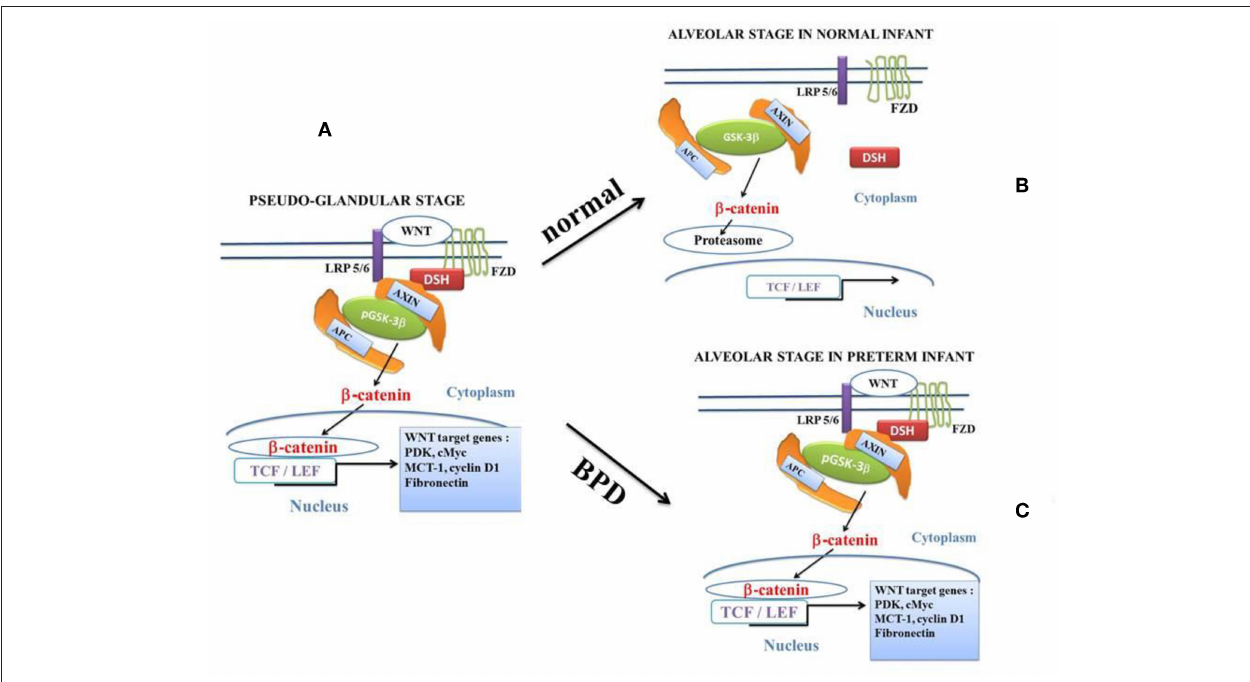
FIGURE 2 | The canonical β -catenin/WNT pathway: “on” and “off” states. The hallmark of the canonical β -catenin/WNT pathway activation is the elevation of the cytoplasmic β -catenin protein level, the subsequent nuclear translocation of β -catenin and further activation of β -catenin specific gene transcription. The canonical β -catenin/WNT pathway can be either in “on-state” or in “off-state.” The pathway is in “on-state” in the presence of a WNT ligand that binds both Frizzled (FZD) and LRP5/6receptors. This leads to activation of the phosphoprotein Disheveled (DSH). DSH recruits the destruction complex (pGSK-3 β + AXIN + APC) to the plasma membrane, where AXIN directly binds the cytoplasmic tail of LRP5/6. APC is the adenomatous polyposis coli and GSK-3 β is the glycogen synthase kinase-3 β . In “on-state,” pGSK-3 β is inactivated which corresponds to the phosphorylated state (pGSK-3 β ). Activation of DSH leads to the inhibition of both phosphorylation and degradation of beta-catenin. Beta-catenin accumulates into the cytosol and then translocates to the nucleus to bind lymphoid-enhancing/T cell (LEF-TCF) co-transcription factors. This induces the WNT-response gene transcription. In the “off state,” in the absence of WNT ligand or in the presence of the active form of GSK-3 β (i.e., the unphosphorylated form of GSK-3 β ), cytosolic β -catenin is phosphorylated by the active form of GSK-3 β . Beta-catenin undergoes the destruction process into the proteasome. (A) : at the pseudo-glandular stage of the pulmonary development, the canonical WNT/ β -catenin pathway is in “on-state.” (B) : at the saccular and alveolar states, and in normal infants, the canonical WNT/ β -catenin pathway is in “off-state.” The pulmonary development is normal. (C) : at the saccular and alveolar states, in preterm infants with BPD, the canonical WNT/ β -catenin pathway is in “on-state” and the pulmonary development is dramatically